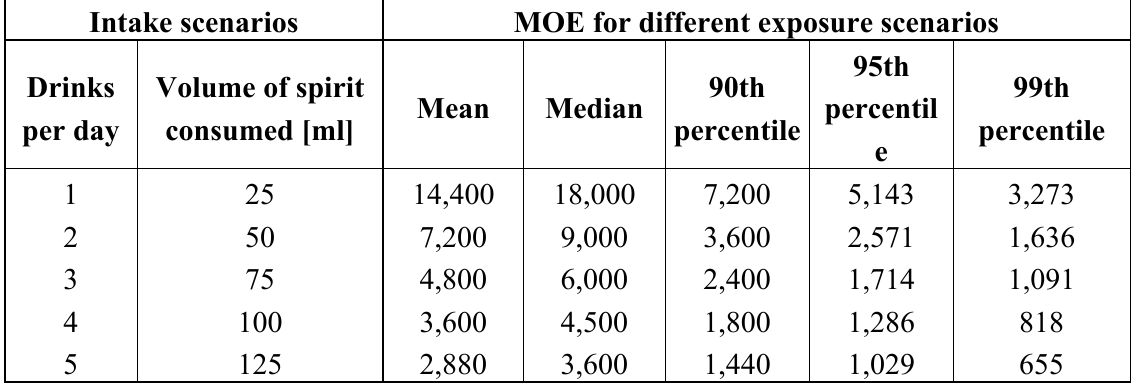
Table 5. Margin of Exposure (MOE) for ethyl carbamate due to agave spirits